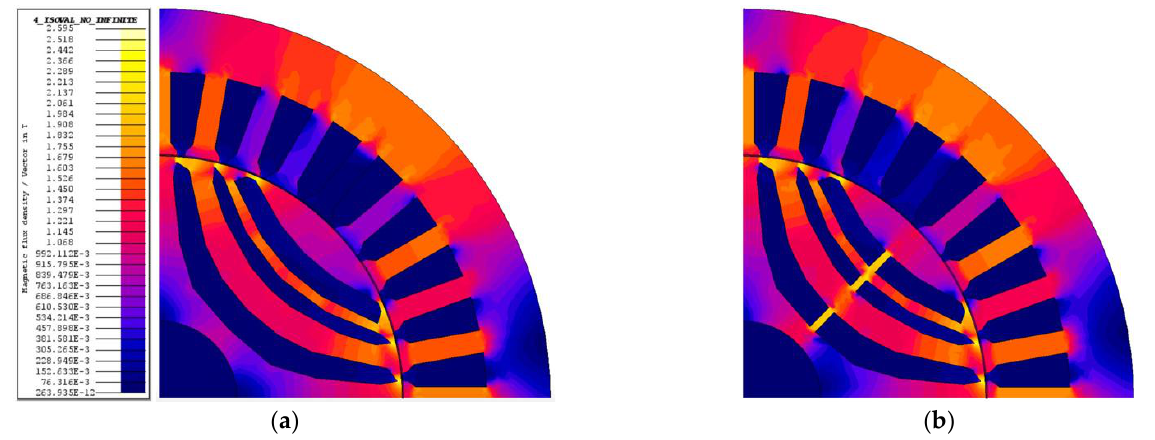
Figure 15. Color maps of the magnetic flux density obtained by means of simulation for the two extreme cases: ( a ) absence of ribs; ( b ) rib thickness equal to 2.5 mm.